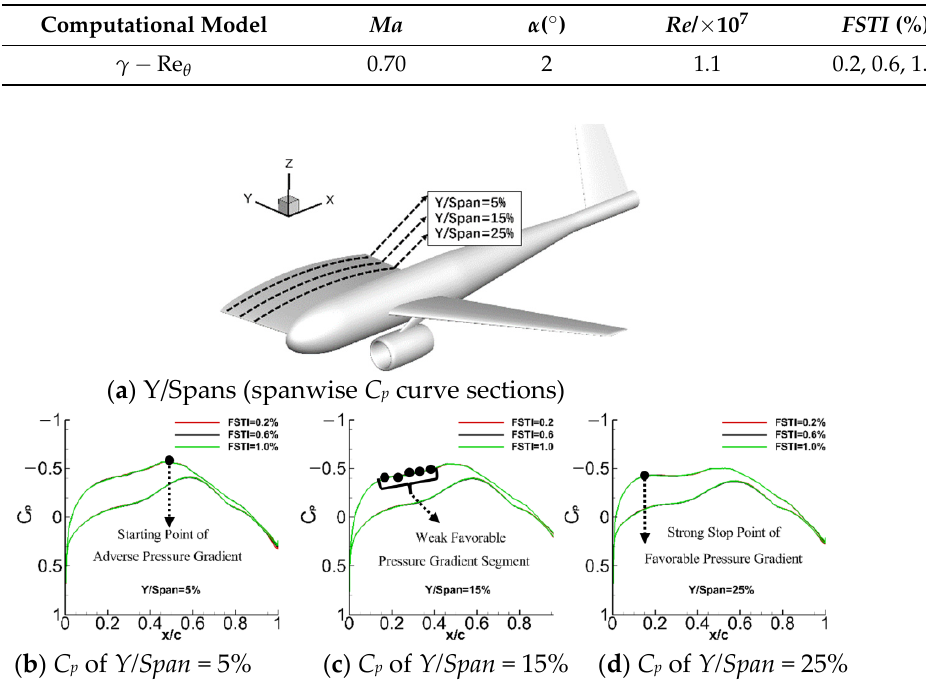
Figure 9. Comparison of C p curves of the central experiment wing with different free stream turbu- lence intensity at various locations along the span.